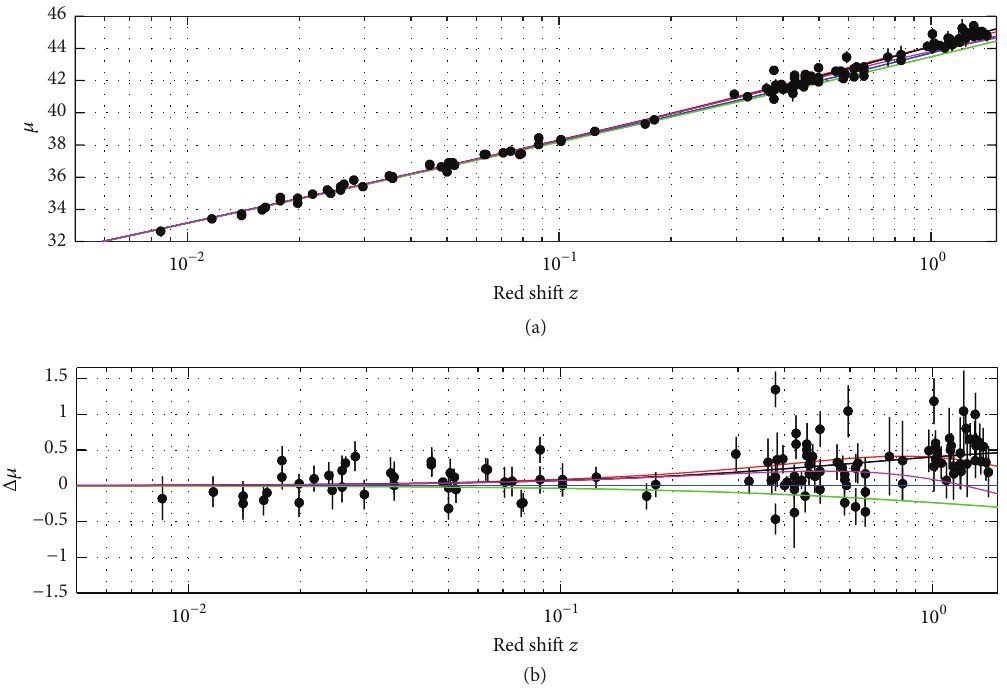
Figure 1: (a) Variation of distance modulus 𝜇 with red shift 𝑧 . (b) The residuals in distance modulus relative to the open universe (shown by the blue curve) that expands forever. In both panels, data from [3] are superposed as in Figure 4 of [34]. The green curve shows matter-only universe that collapses on itself. Black curve shows the current constant 𝐺 - Λ model with Ω Λ0 of 0.73. The red and magenta curves correspond to the proposed variable 𝐺 - Λ model with Ω Λ0 of 0.82 and 0.73, respectively (see the text for more details).